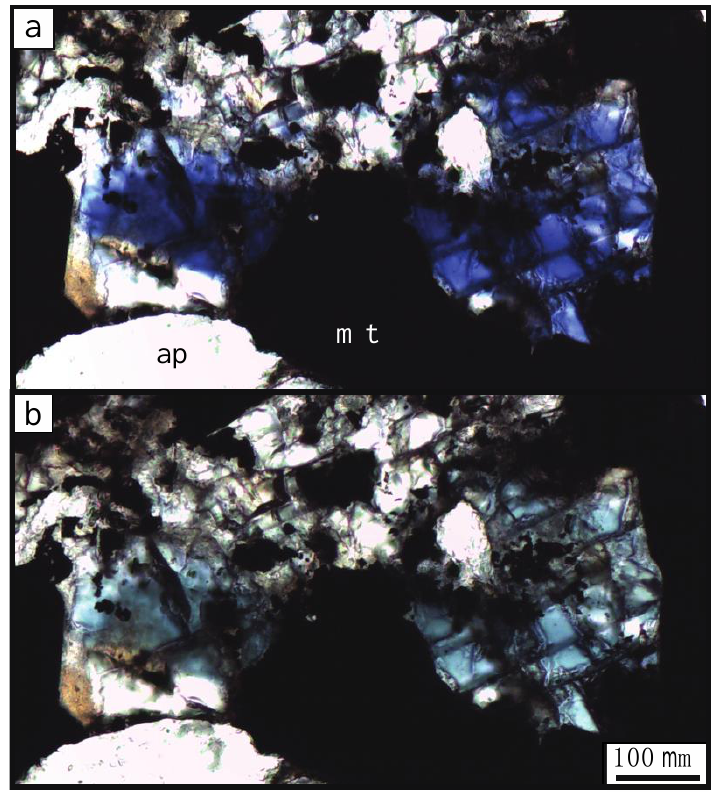
Figure 5. Photomicrographs of sapphire grain surrounded by magnetite (mt) and apatite (ap) showing parting and range of pleochroism in plane polarized light, ( a ) dark blue color of corundum when omega-ray ( ω -ray) is oriented parallel to lower polar, ( b ) light blue color of corundum when epsilon-ray ( ε -ray) is oriented parallel to lower polar.